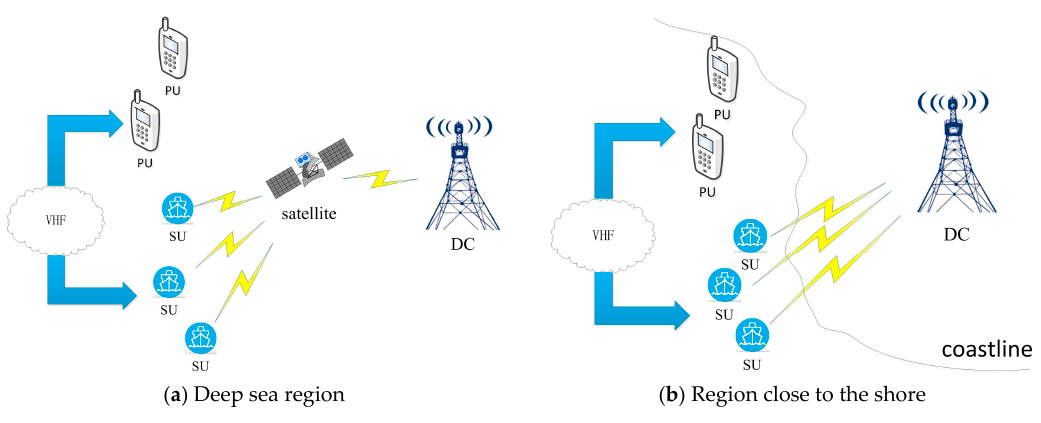
Figure 1. System Components.